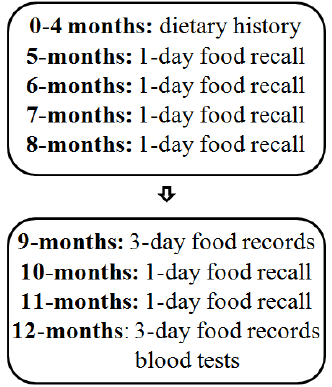
Figure 1. Flowchart on the progress of the